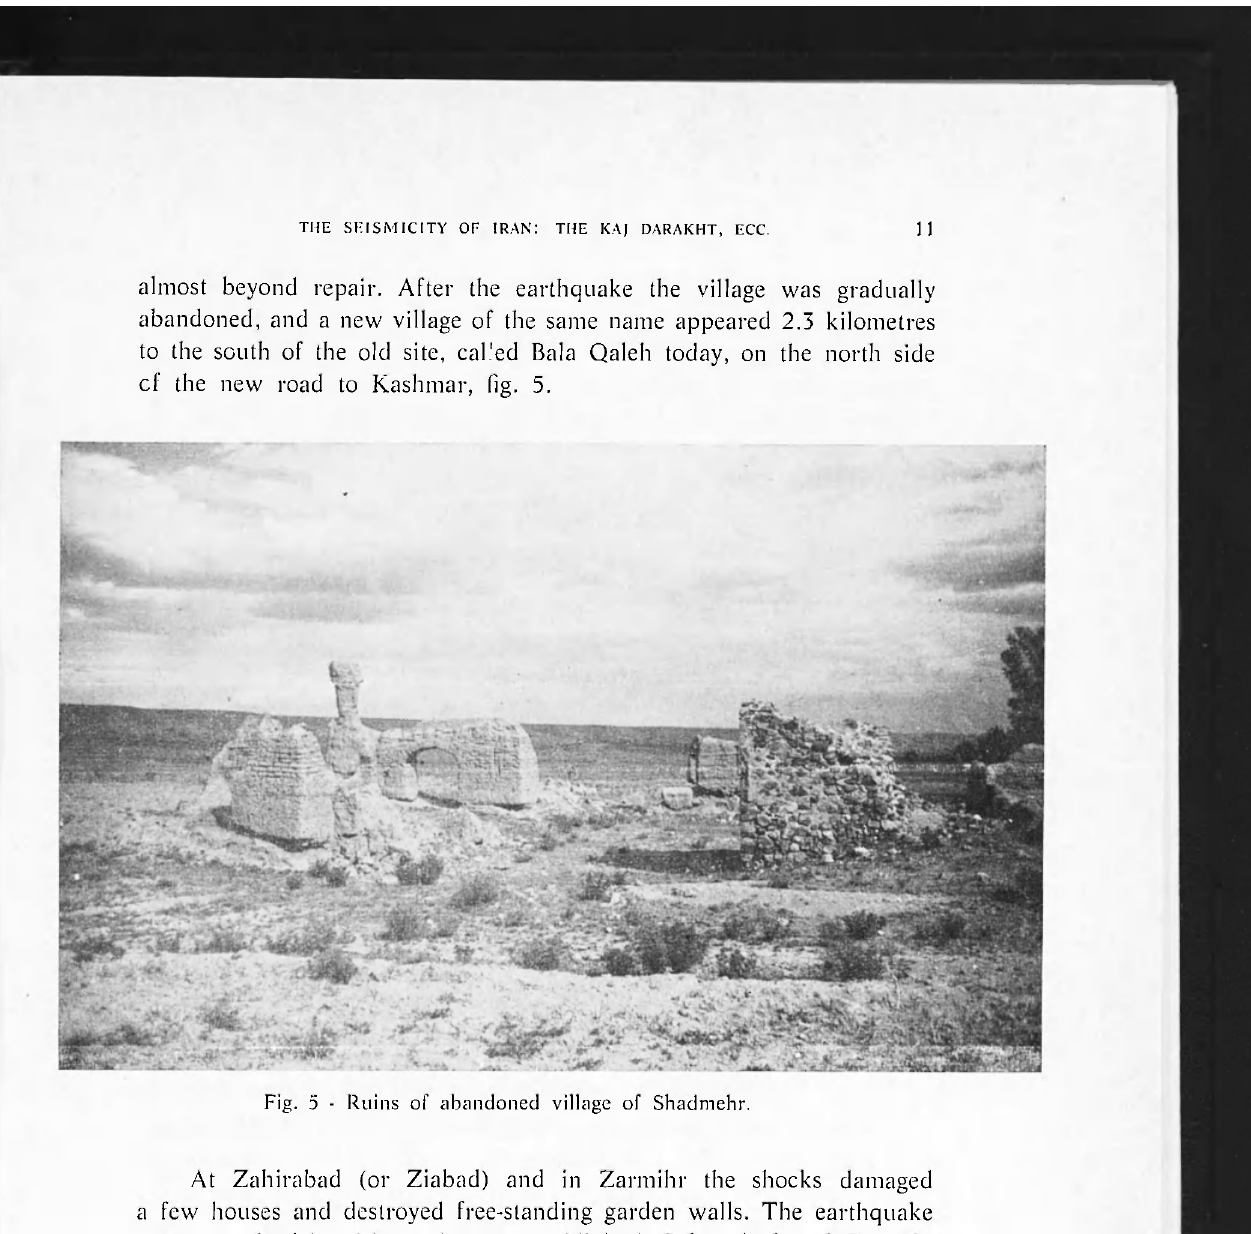
Fig. 5 - Ruins of abandoned village of